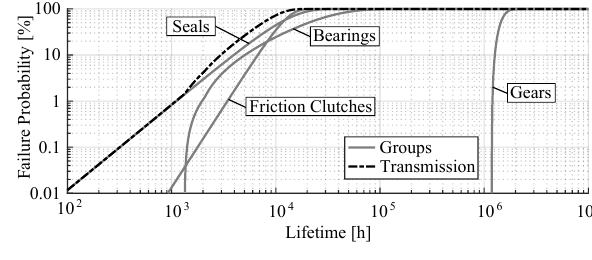
Figure 11: Failure